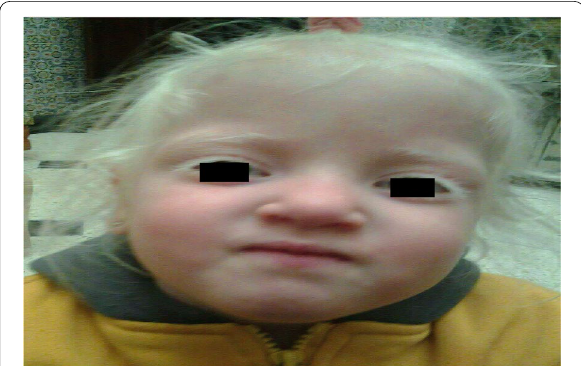
Fig. 2 The girl’s image (proband IV-1) showing generalized skin hypo-pigmentation with blond hair, eyelashes, and eyebrows giving the “snow white”